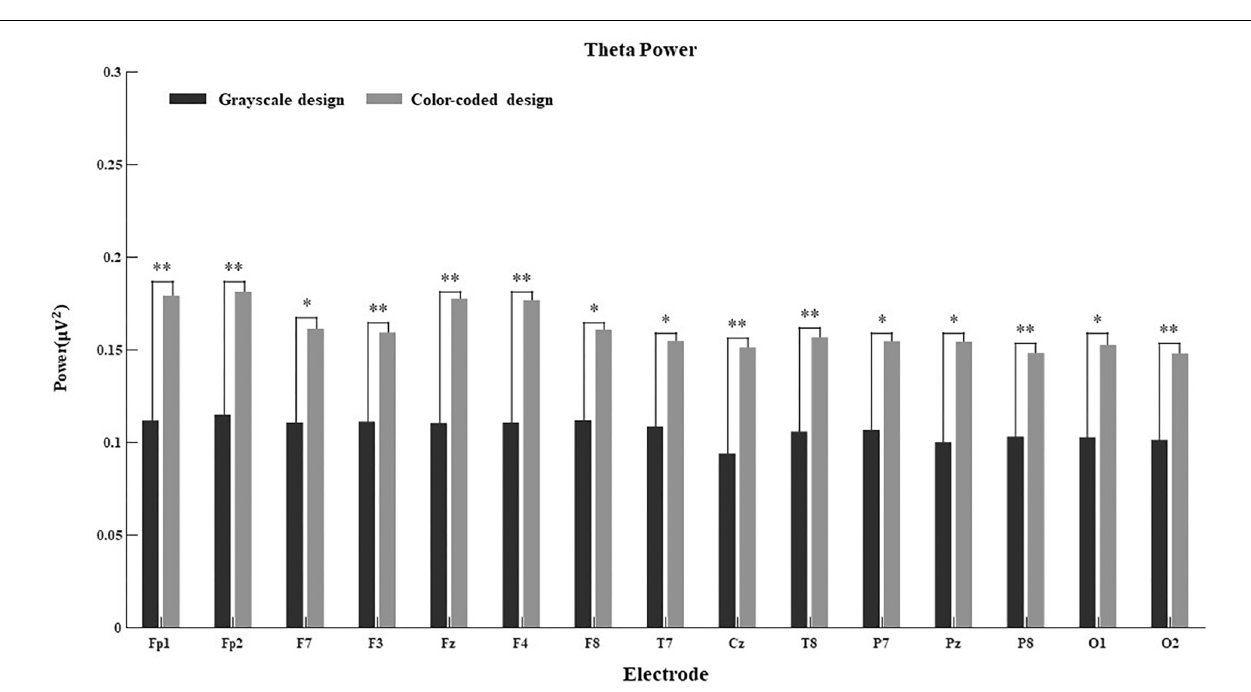
FIGURE 5 | Theta power for the 15 electrodes in the grayscale and color-coded conditions while watching video lectures ( ∗ p < 0.05, ∗∗ p <